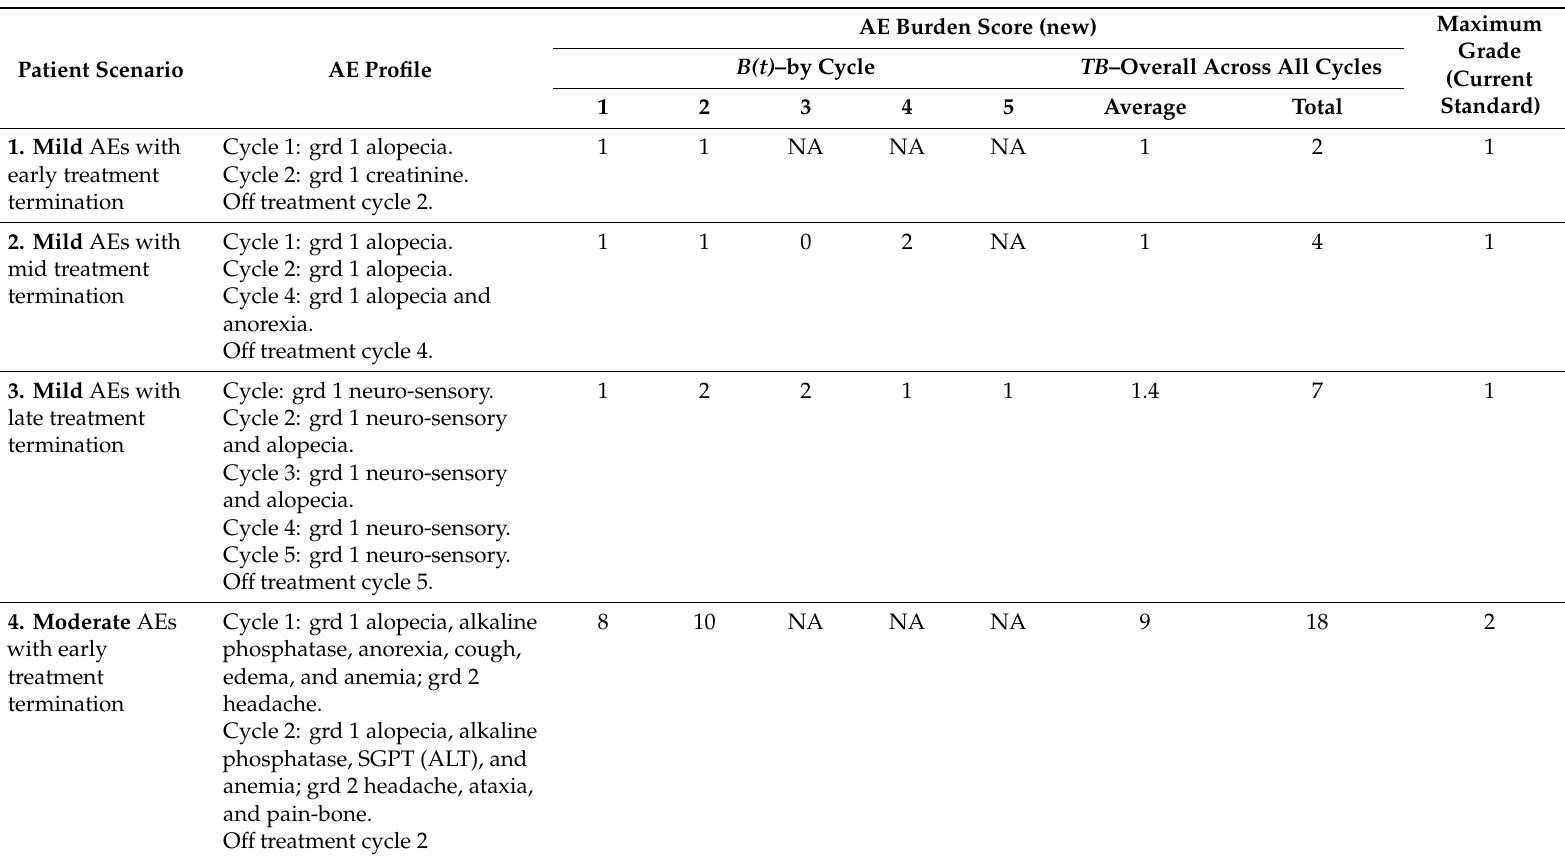
Table 1. Adverse event (AE) burden scores for various AE profiles (from real patients) compared to the current reporting standard of maximum grade (Mild: Grade 1, Moderate: Grade 2, Severe: Grade 3 + , early termination: cycle 1–2, mid termination: cycle 3–4, late termination: cycle